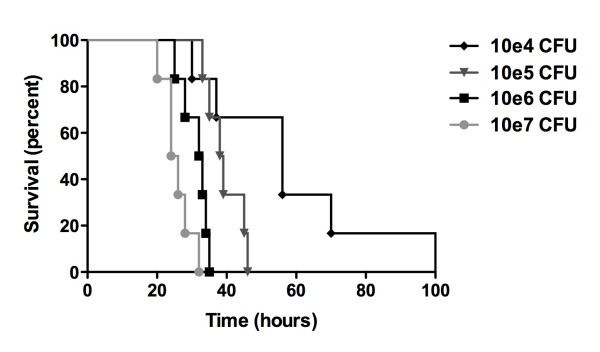
Kaplan-Meier survival curve. Four groups of 6 mice inoculated via direct intracisternal injection with 104, 105, 106 and 107 CFU of S. pneumoniae/mouse respectively.